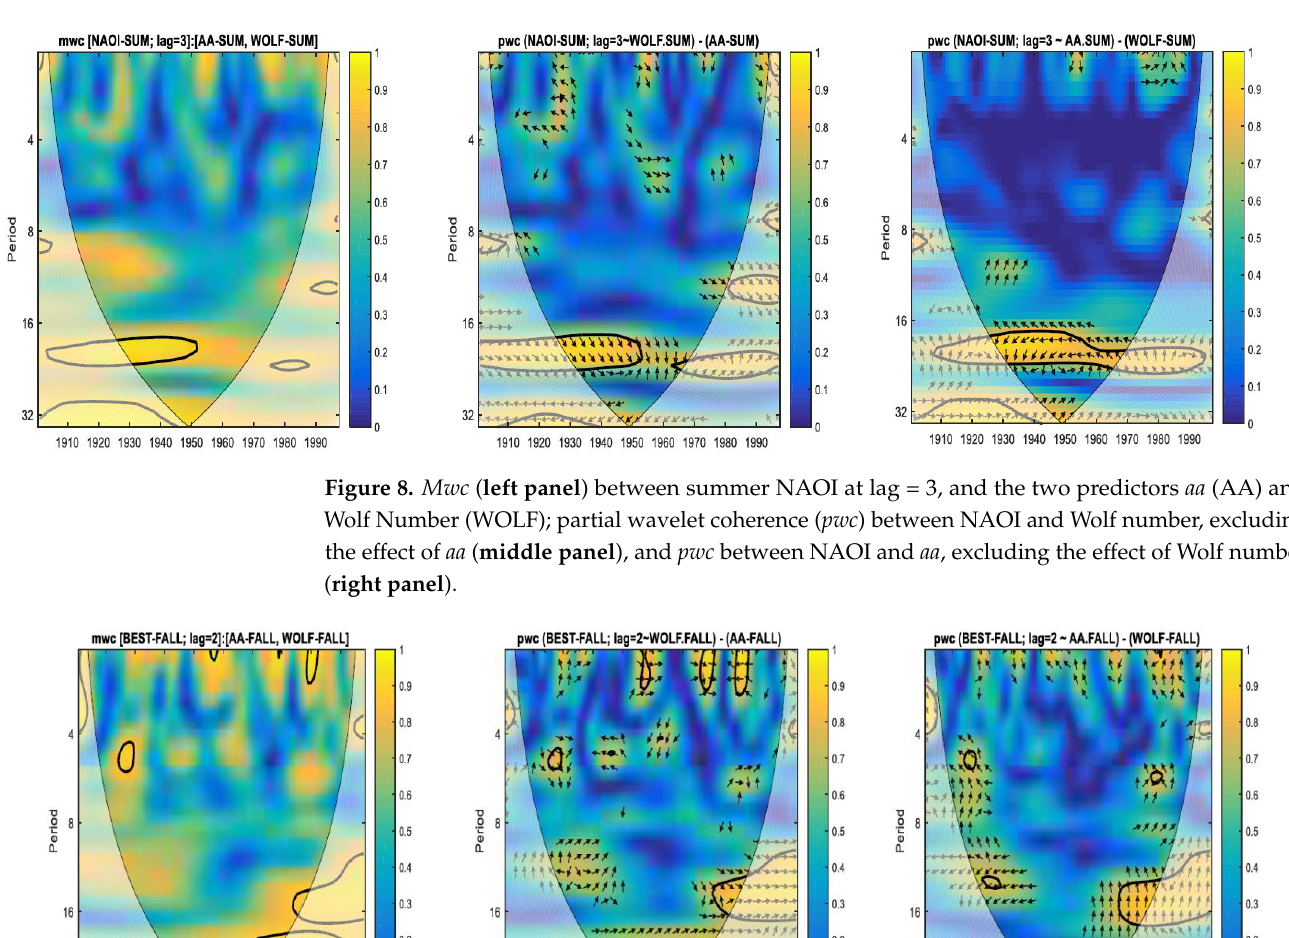
Figure 9. Mwc ( left panel ) between fall BEST at lag = 2, and the two predictors aa (AA) and Wolf Number (WOLF); partial wavelet coherence ( pwc ) between BEST and Wolf number, excluding the effect of aa ( middle panel ), and pwc between BEST and aa , excluding the effect of Wolf number ( right panel ).